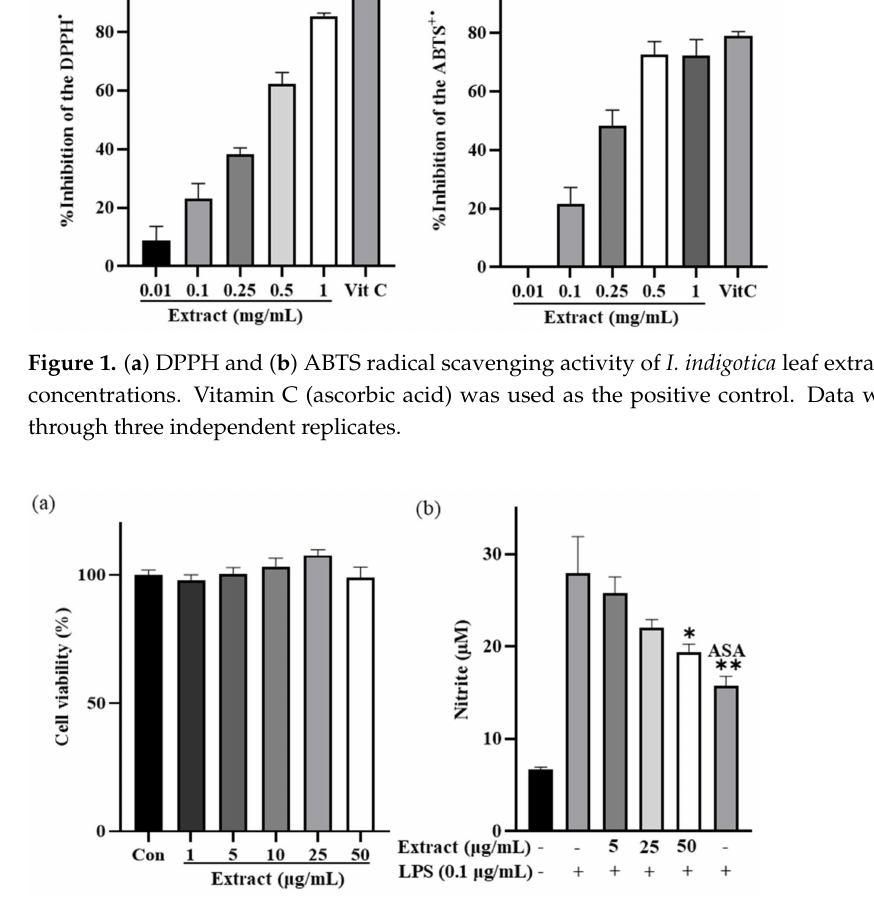
Figure 2. ( a ) Cell viability and ( b ) inhibitory activity of nitrite production in RAW 264.7 macrophages after treatment with different concentrations of I. indigotica leaf extract. RAW 264.7 macrophages were incubated with 0.1 µ g/mL of lipopolysaccharide for 18 h. Acetylsalicylic acid (ASA) was used as the positive control. Data were obtained through three independent replicates. * and ** indicate significant differences at 0.05 and 0.01 significance level,